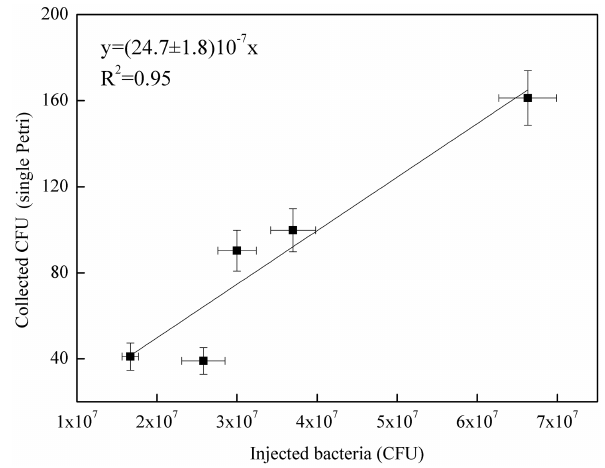
Figure 4. Typical grow curve for Bacillus subtilis (black line, cir- cle) and Escherichia coli (red line, triangle): optical density (OD 600nm) and the corresponding bacteria concentration (CFUml − 1 ) are plotted vs. time. Data of concentration curves are reported until the stationary phase.